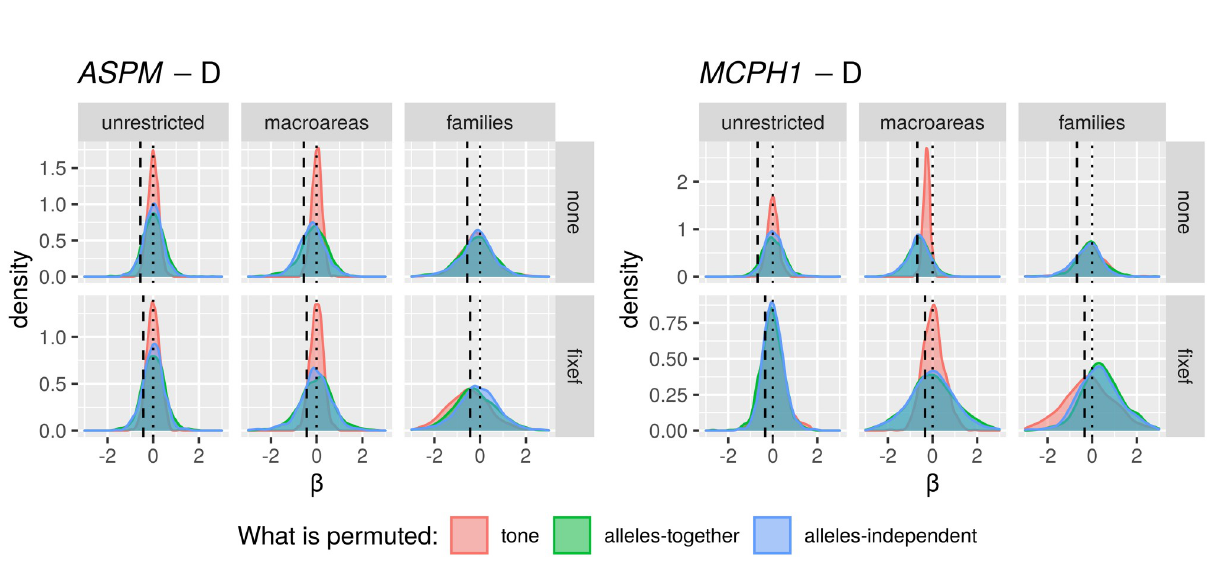
Fig 18. Distribution of the permutation regressions for tone2 . Same conventions as in Fig 9.